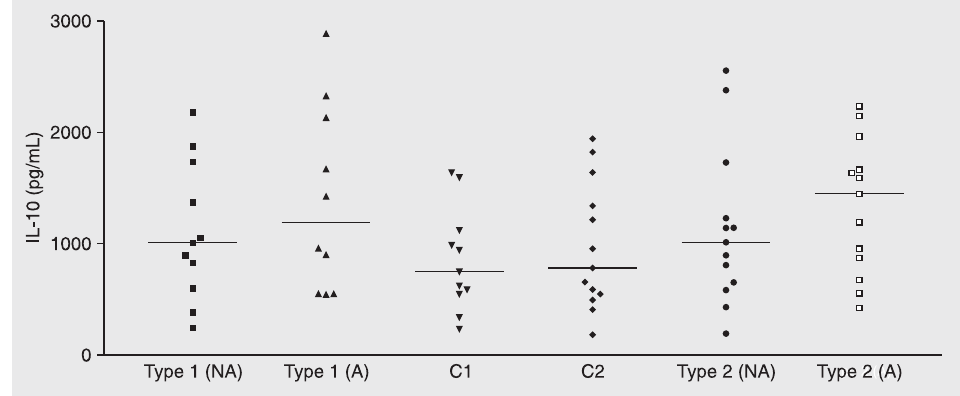
Figure 3. IL-10 levels in culture supernatants of peripheral blood mononuclear cells (PBMC) from type 1 and 2 diabetic patients having inadequate (NA) or adequate (A) metabolic control and normal individuals (control 1 (C1) and control 2 (C2) paired by sex and age with type 1 and 2 diabetic patients, respectively). The increase in IL-10 levels in the PBMC culture supernatants of A type 2 diabetic patients compared to C2 was not statistically significant (P = 0.09; Kruskal-Wallis test). The horizontal lines indicate the median for each